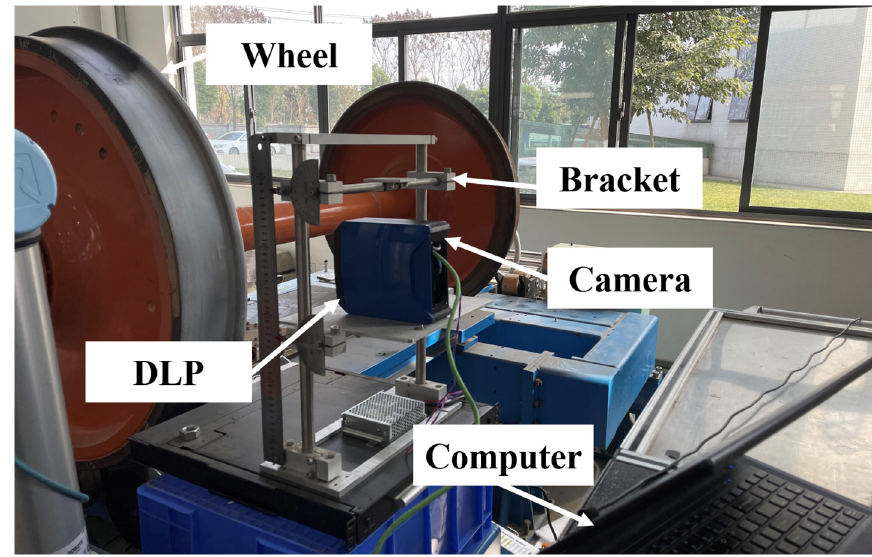
Figure 12. Wheel tread detection experimental platform.